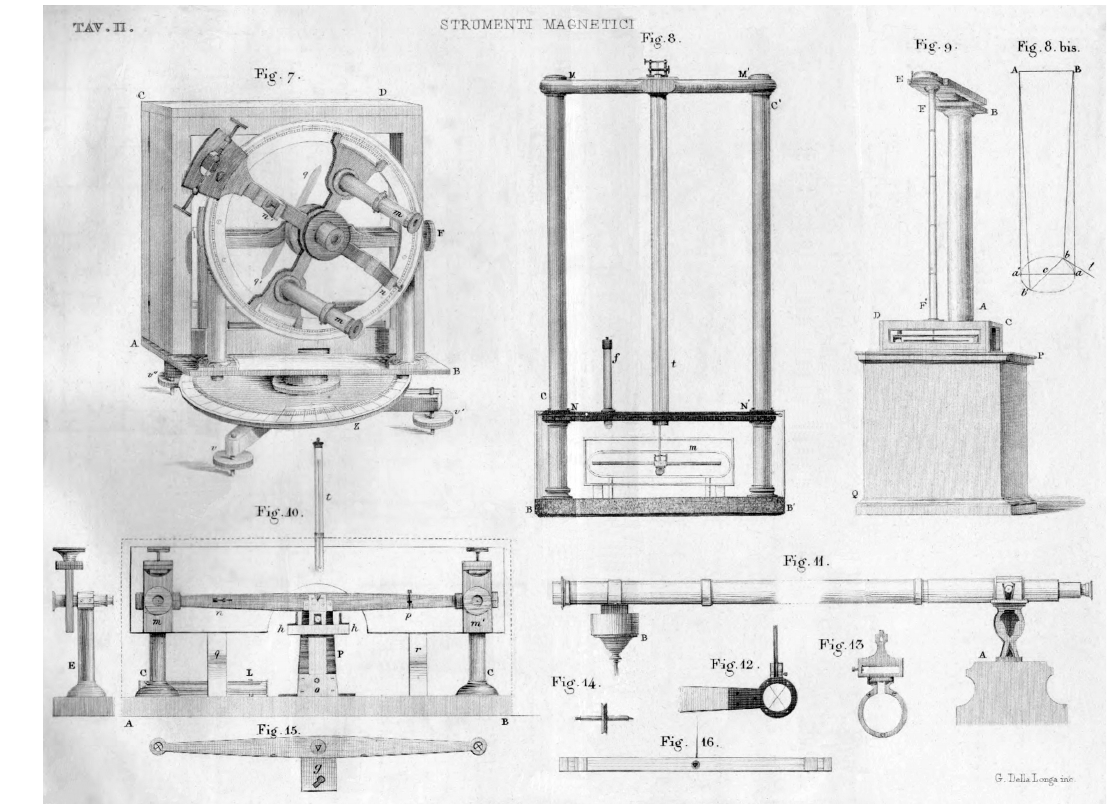
Figure 7. Plate II (“Tav. II”) showing the instruments installed in the Collegio Romano Magnetic Observatory (Secchi,